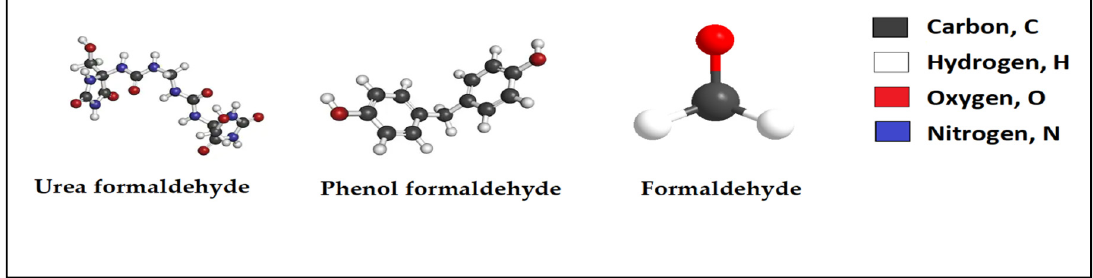
Figure 3. Chemical structure of urea formaldehyde, phenol formaldehyde, and formaldehyde.